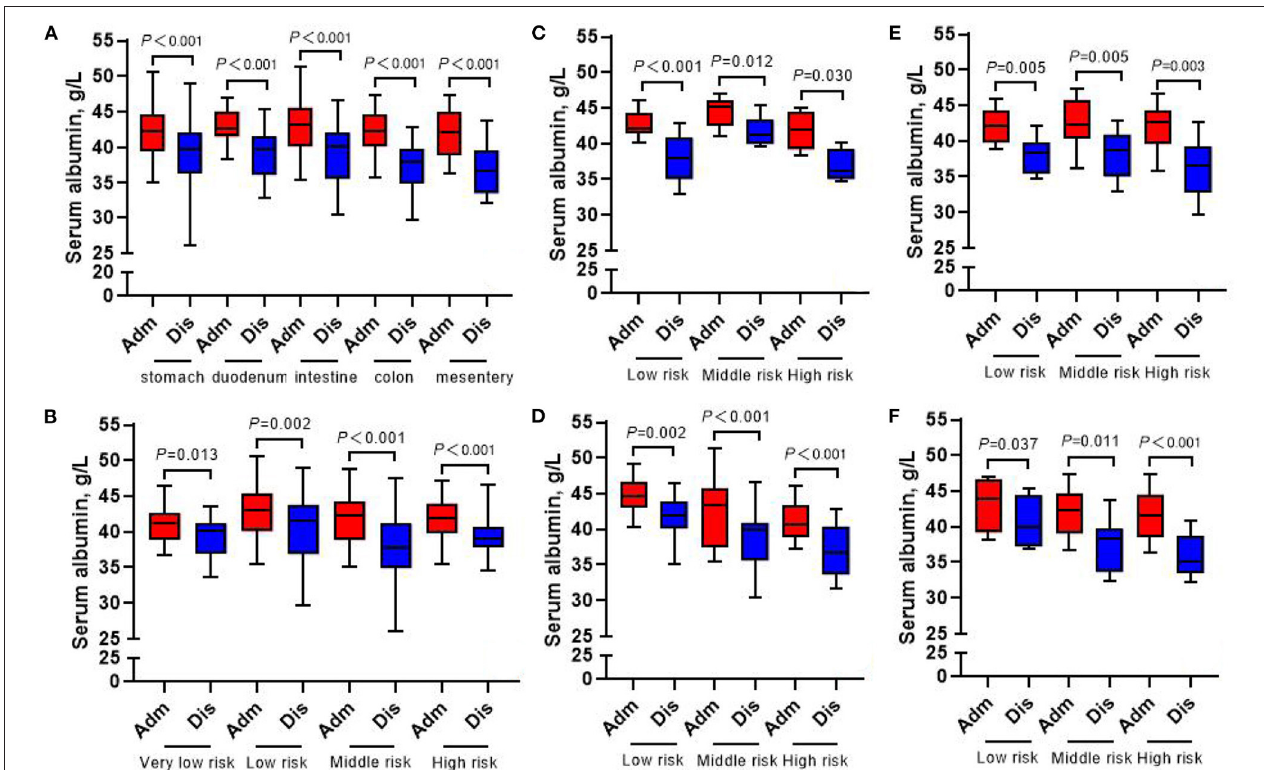
FIGURE 8 | Changes of serum albumin in 413 GIST patients at admission and discharge. (A) Total; (B) stomach; (C) duodenum; (D) intestine; (E) colorectal; (F) mesentery.